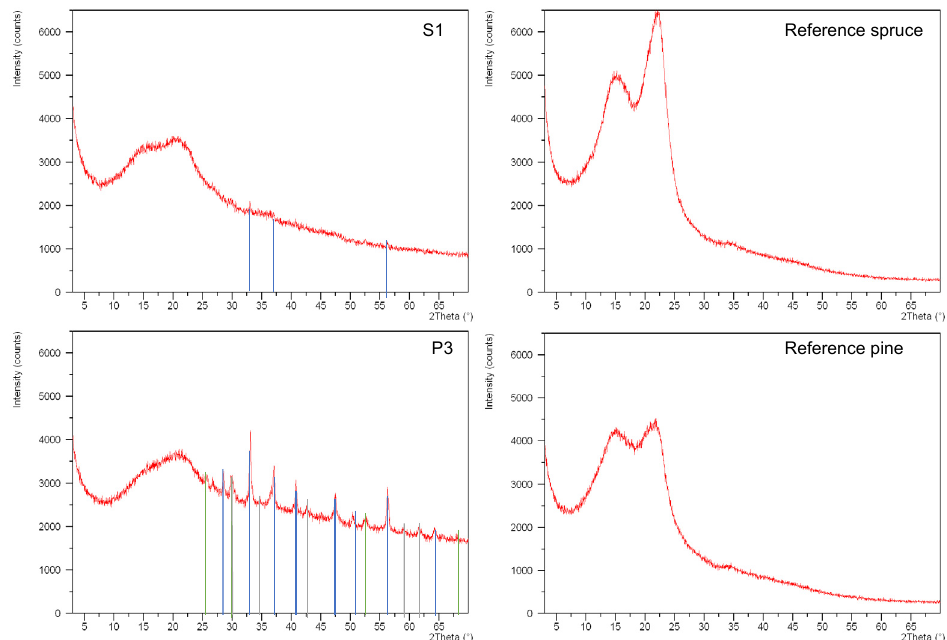
Figure 7. X-ray patterns of samples S1 and P3 with related spruce and pine references (in blue lines diffraction peaks of pyrite, in green greigite, in gray magnetite).